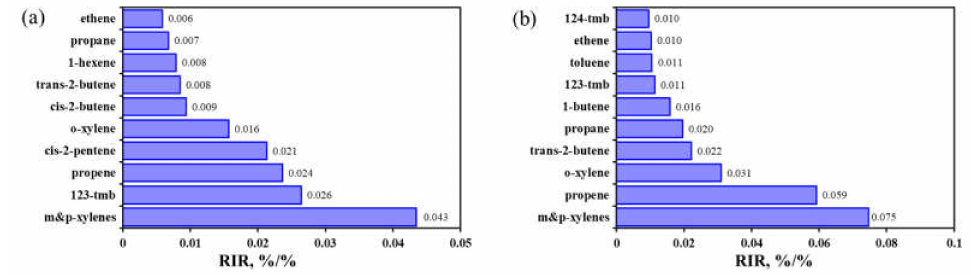
Figure 8. Species with the top ten relative incremental reactivity ( RIR ) values at the ( a ) DSH and ( b ) PD